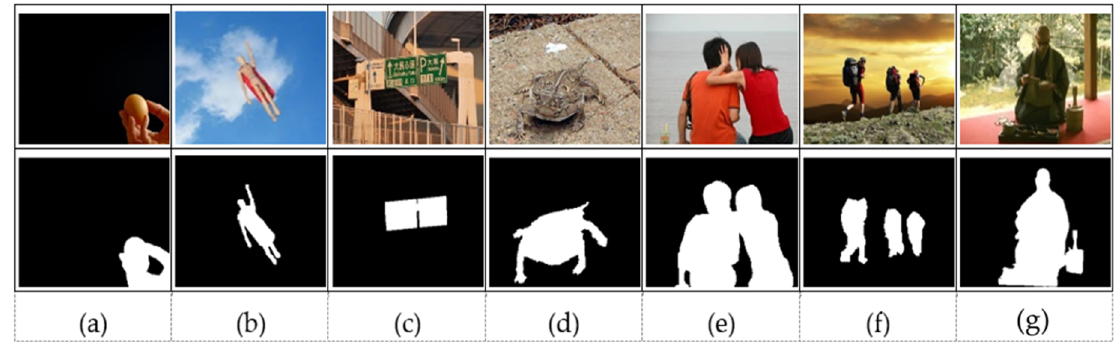
Figure 2. Category of images: ( a ) boundary; ( b ) center; ( c ) complex background; ( d ) low contrast; ( e ) overlap; ( f ) multiple objects; ( g )